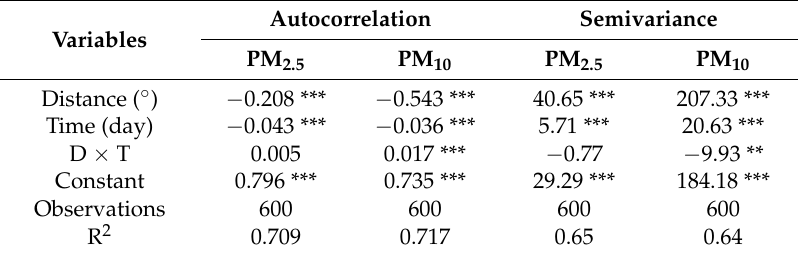
Table 1. Regression of autocorrelation and semivariance with respect to distance and time intervals. Autocorrelation Variables